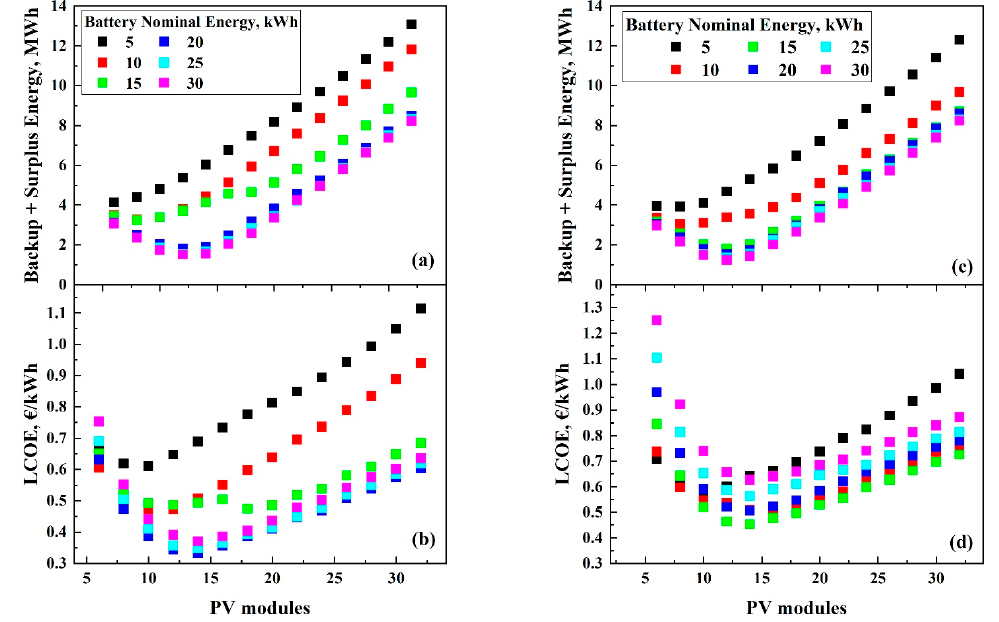
Figure 9. Each marker chart unfolds the optimal N –Bnec arrangement in terms of maximal solar energy usage ( a , c ) and LCOE minimization ( b , d ). Charts 9a and 9b show all the simulation instances of the lead–acid system, while charts 9c and 9d show the results of the lithium-ion